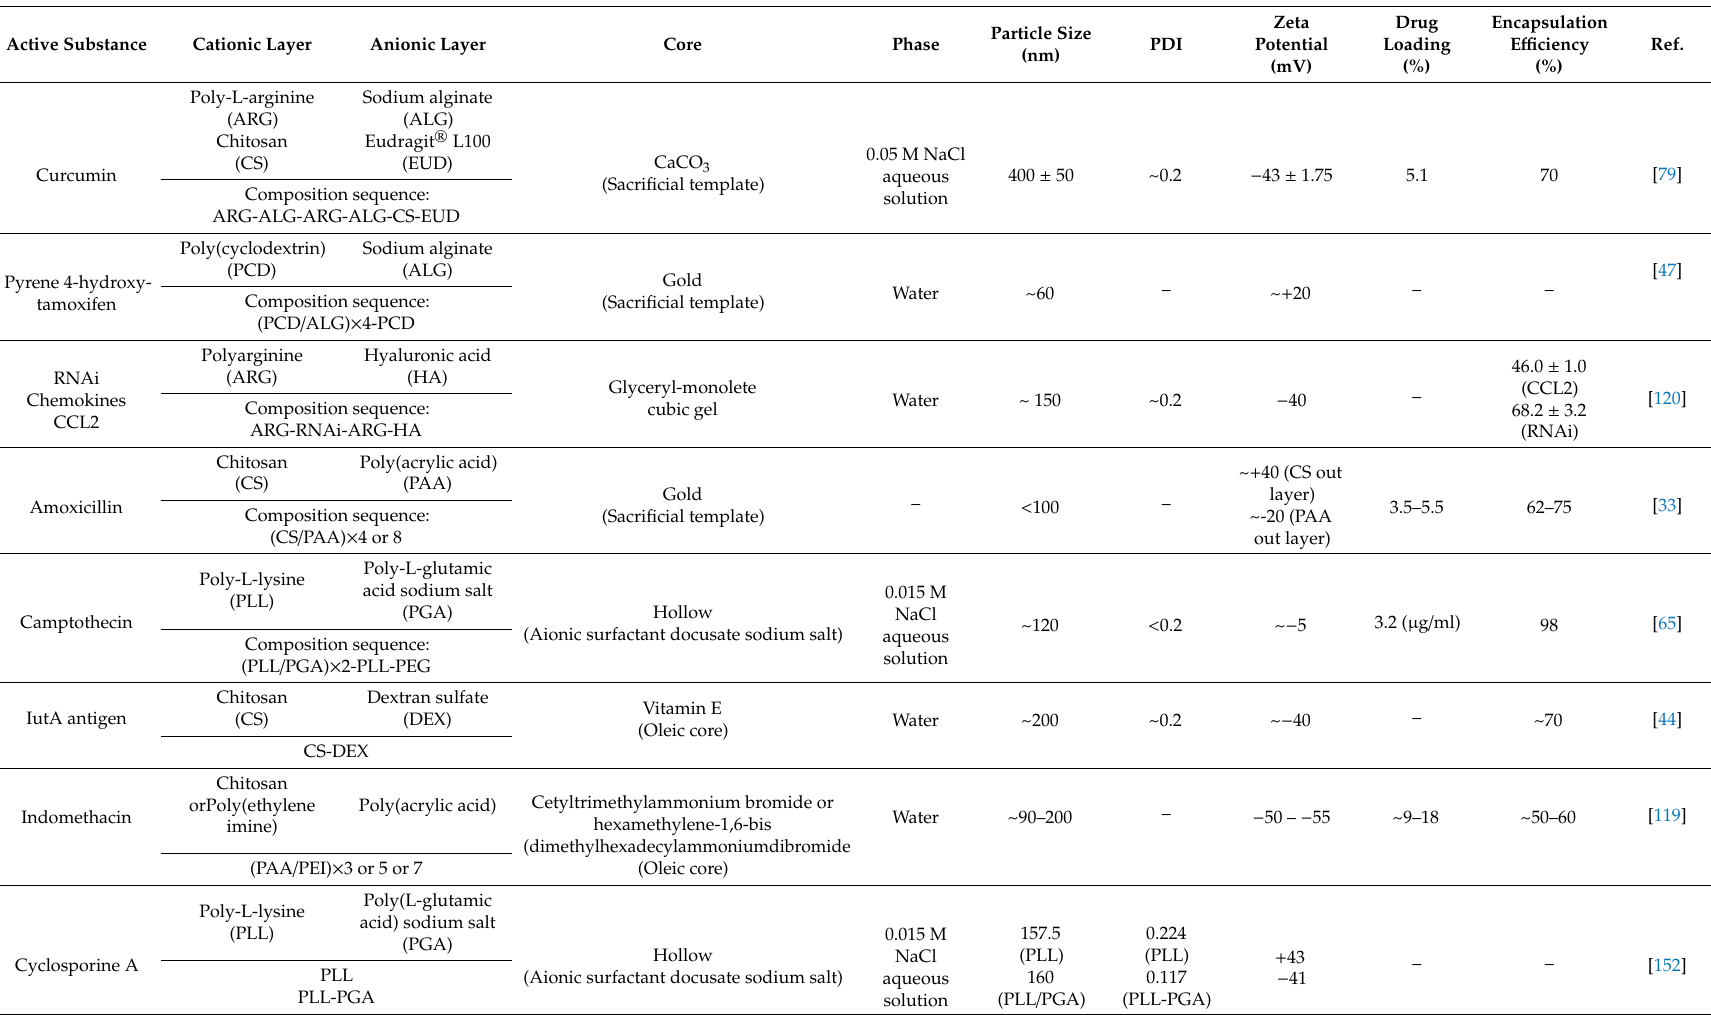
Table 5. Examples of polymeric nanocapsule formulation by layer-by-layer methods in recent five